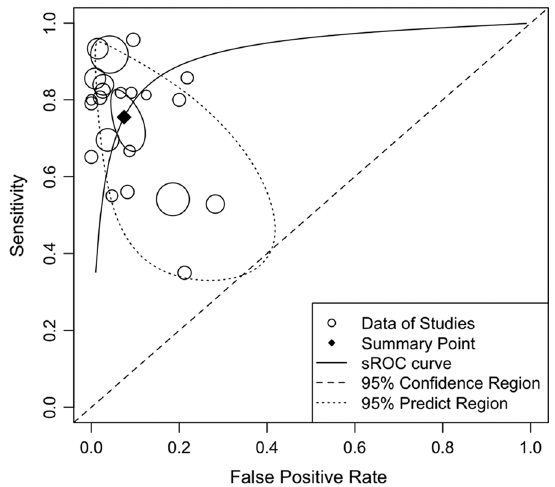
Fig. 3 sROC curve of the halo sign in temporal arteries for GCA